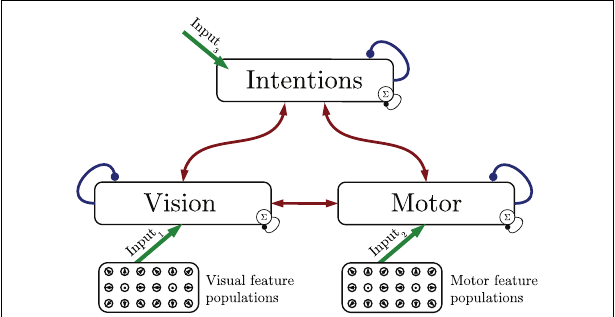
FIGURE 1 | Architecture overview in the context of action inference and simulation . The model consists of three stochastic layers: a vision layer , a motor layer , and an intention layer . All layers predict the next state in other layers (red arrows) and the next state in the same layer (blue arrows). The vision and motor layers can be driven by sensory, bottom-up signals (green arrows 1 and 2), while the top layer can be driven by top-down signal input (green arrow 3). Normalization of a layer input is indicated by the circled (cid:6) .